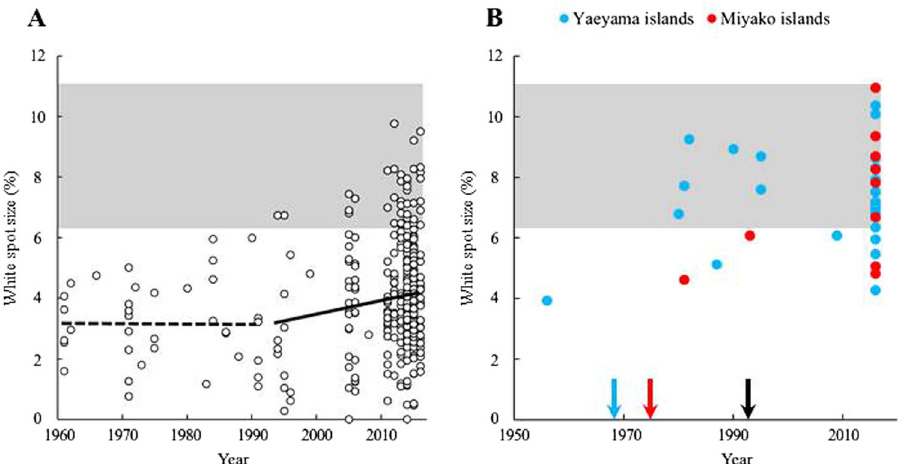
Figure 2. ( A ) Change in the white spot size (as a percentage of hind-wing area) of P . polytes f. polytes over the last 55 years on Okinawa. The dashed line is the regression of the white spot size before the new model’s settlement (1961–1991); the solid line is the regression after the new model’s settlement (1994–2016). The grey band represents the range of the mean ± 2SD of the model, P . aristolochiae . ( B ) Change in the white spot size of f. polytes in the Miyako group (red dot: including Miyako and Irabu islands) and the Yaeyama group (blue dot: Ishigaki, Hateruma and Iriomote islands). The grey band is the range of the white spot size of the model. The arrows show the years when P . aristolochiae established populations on each